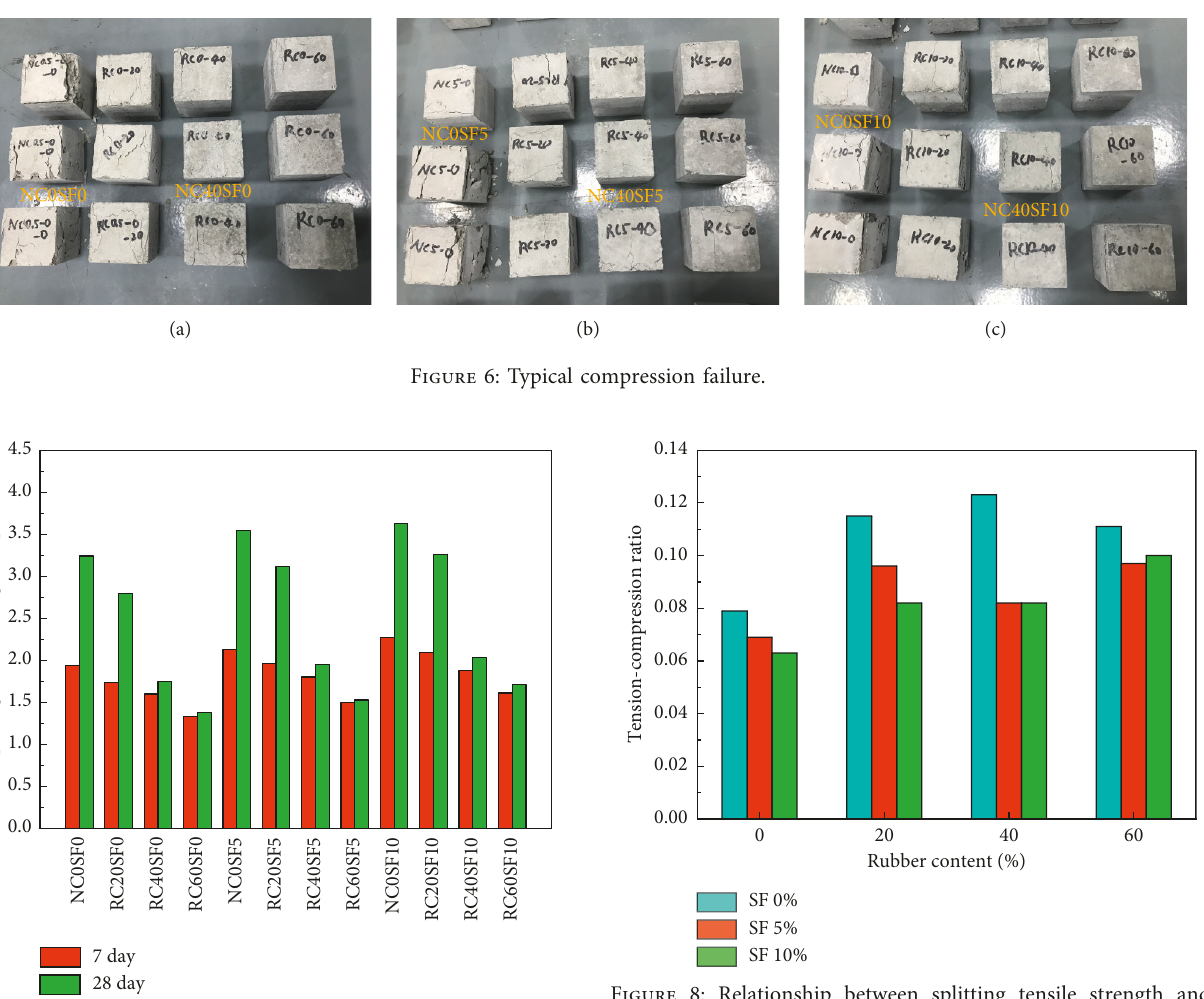
Figure 7: Splitting tensile strength at days 7 and 28.